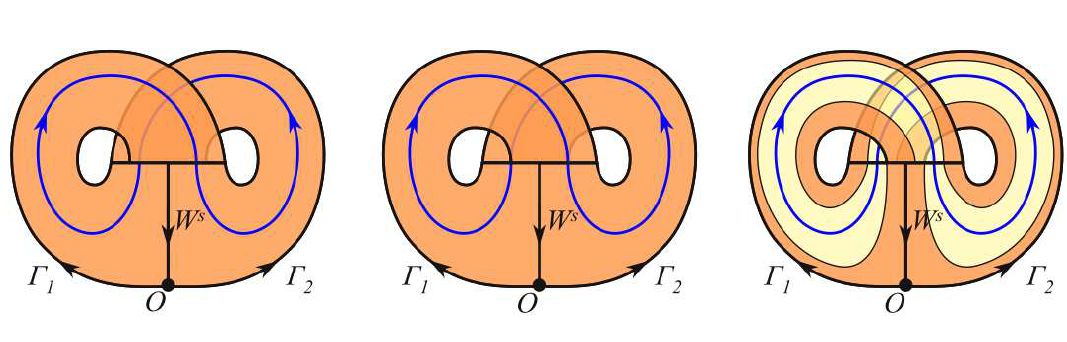
Fig. 10 Sketch of creation of the trivial